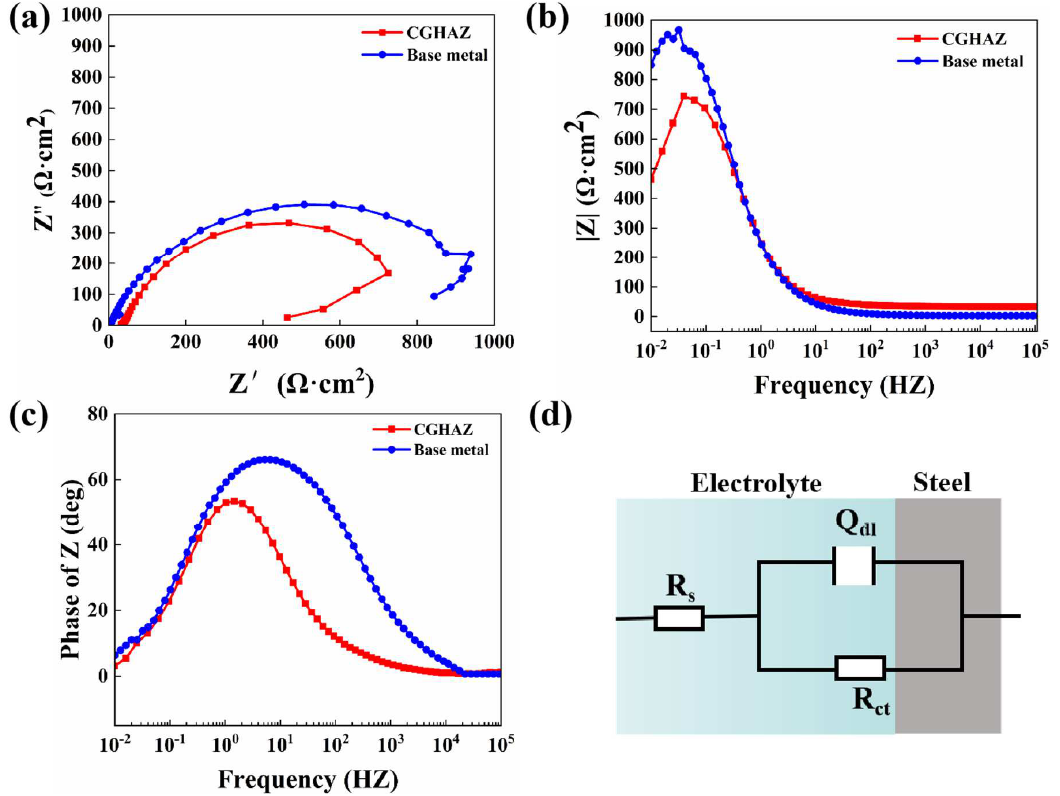
Table 4. Electrochemical corrosion parameters of the tested steels.